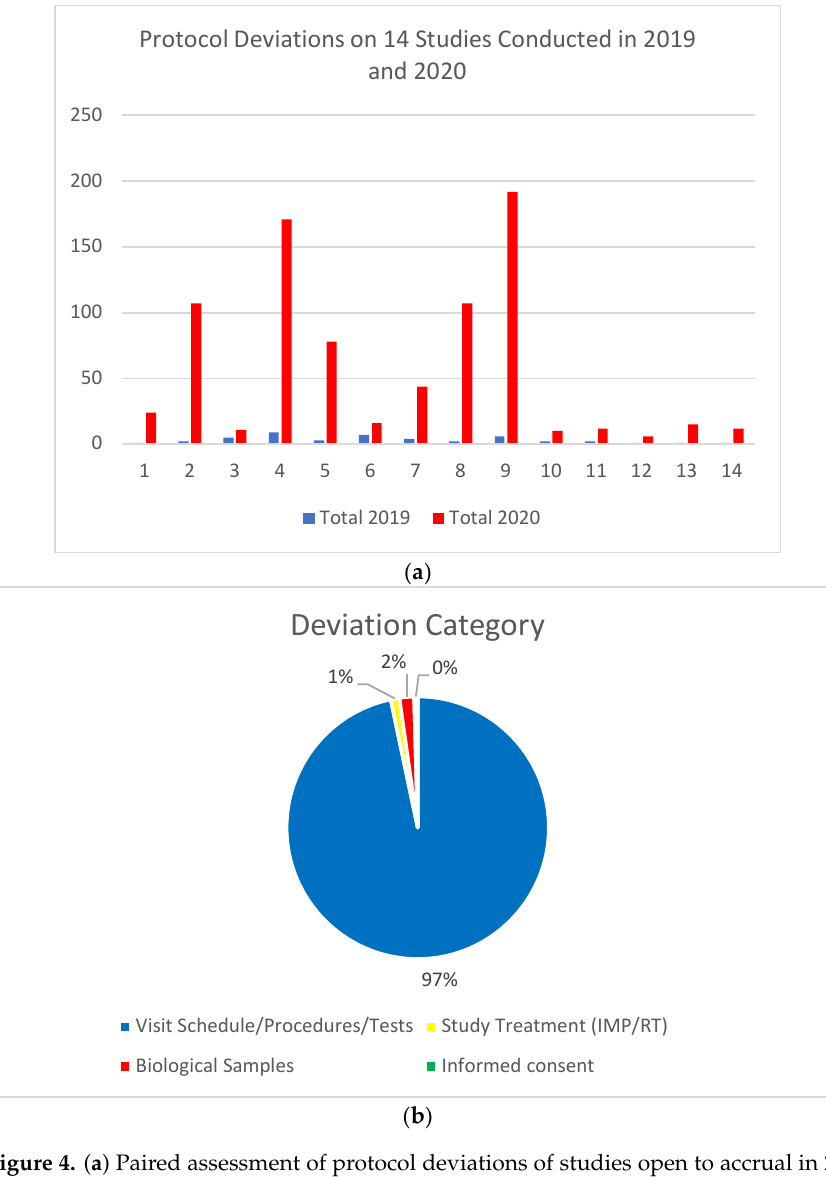
Figure 4: ( a ) Paired assessment of protocol deviations of studies open to accrual in 2019 and 2020; ( b ) categories of protocol deviations observed.